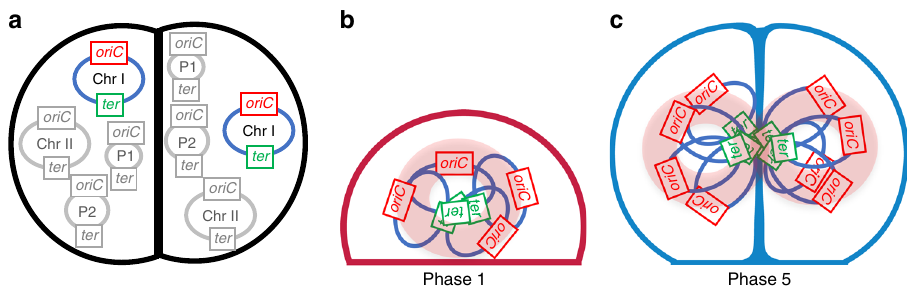
Fig. 7 Radial arrangement and segregation of chromosome 1 in D. radiodurans . a D. radiodurans possesses multiple copies (4 to 10) of four replicons (2 chromosomes: Chromosome 1, Chr1, and chromosome 2, Chr 2, and two plasmids, P1 and P2), each of which possesses an origin of replication ( oriC ) and a termination site ( ter ). For Chr1, the oriC and ter loci are represented in red and in green, respectively. b , c Proposed arrangement of the multiple copies of Chr1 in Phase 1 and 5 cells. Typical nucleoid shapes observed in these two phases (Fig. 3c) are shown in pale pink. Chr1 is present in at least four copies in Phase 1 and this number doubles by the end of the cell cycle (Phase 5). The number of ter foci remains constant and close to 1 for most of the cell cycle, most likely as a result of the clustering of ter loci by an unknown mechanism in the centre of the cell. The oriC loci are radially distributed around the ter loci and are found throughout the cytoplasm with the exception of membrane